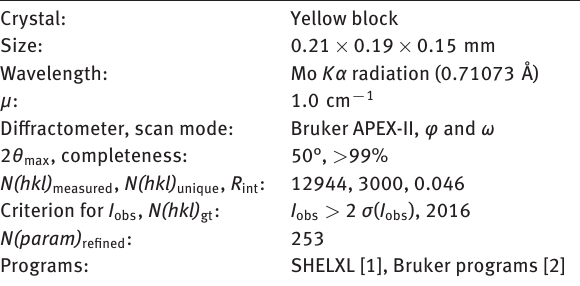
Table 1: Data collection and handling.